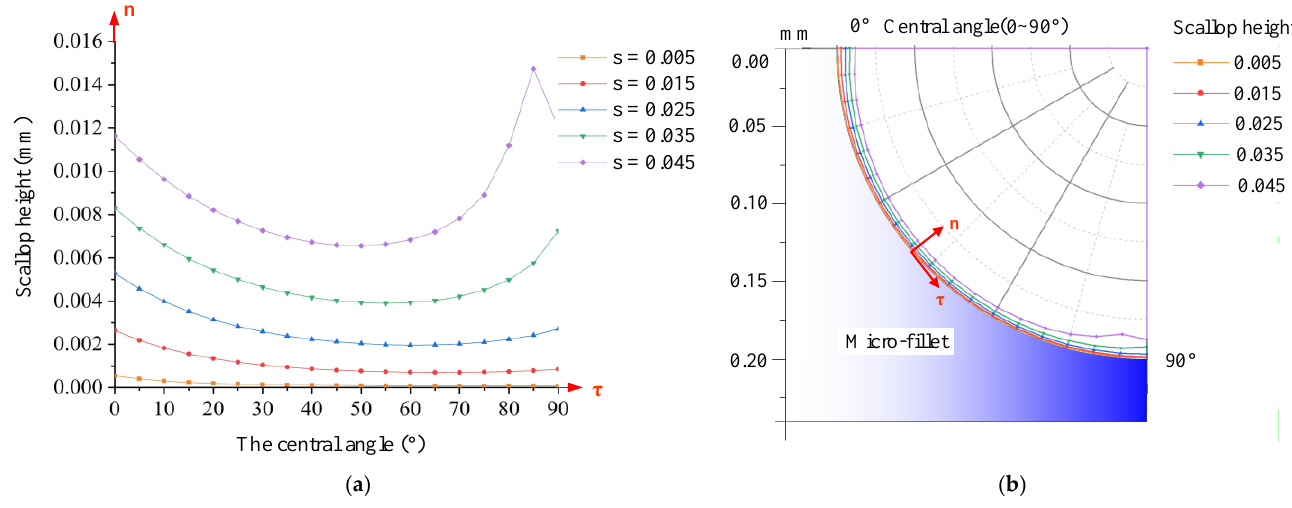
Figure 7. Scallop height at each position of micro-fillet under 0.005–0.045 mm cutting step: ( a ) curve of central angle and scallop height of micro-fillet, and ( b ) theoretical prediction of scallop height curve on micro-fillet.